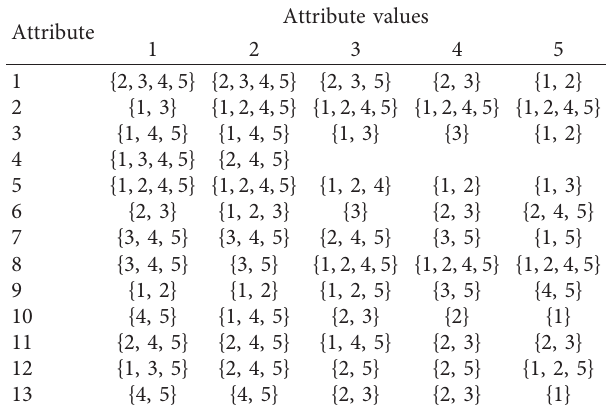
Table 13: Support sets of the attribute values of the Boston housing dataset for a customer having average customer satisfaction (3). The